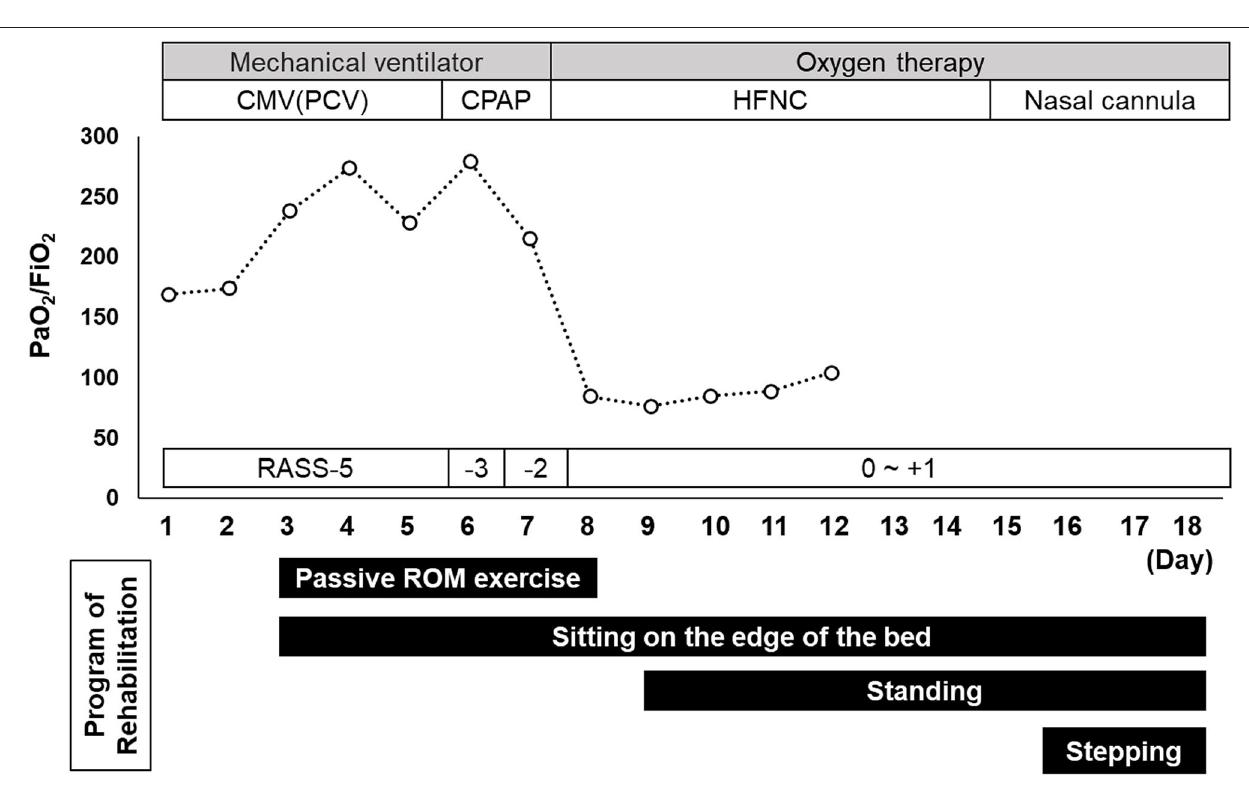
FIGURE 2 | Timeline of the patient’s respiratory management and rehabilitation programs. Data recorded in the management of the patient’s pulmonary condition included the PaO 2 /FiO 2 ratio and Sequential Organ Failure Assessment score. Indicated are the rehabilitation programs used between admission (day 1) and the day of regional hospital transfer (day 18). CMV, continuous mandatory ventilation; CPAP, continuous positive airway pressure; HNFC, high-flow nasal cannula; PCV, pressure-controlled ventilation; RASS, Richmond Agitation-Sedation Scale; ROM, range of